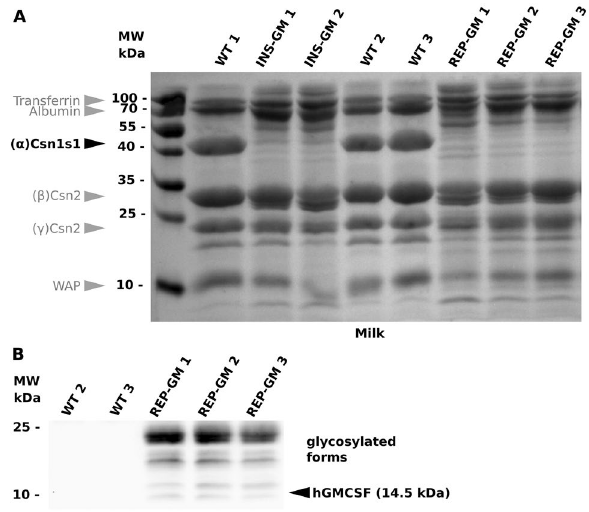
Figure 3. Detection of the hGMCSF in the milk of transgenic mice. ( A ) Total milk protein reversibly stained on a PVDF membrane. WT 1–3—wild-type milk samples; INS-GM 1–2—homozygous INS-GM milk samples; REP-GM 1–3—homozygous REP-GM milk samples. Left lane—protein molecular weight marker (Protein Ladder 10 to 180 kDa). ( B ) Western blot analysis of the REP-GM homozygous milk samples with anti-hGMCSF